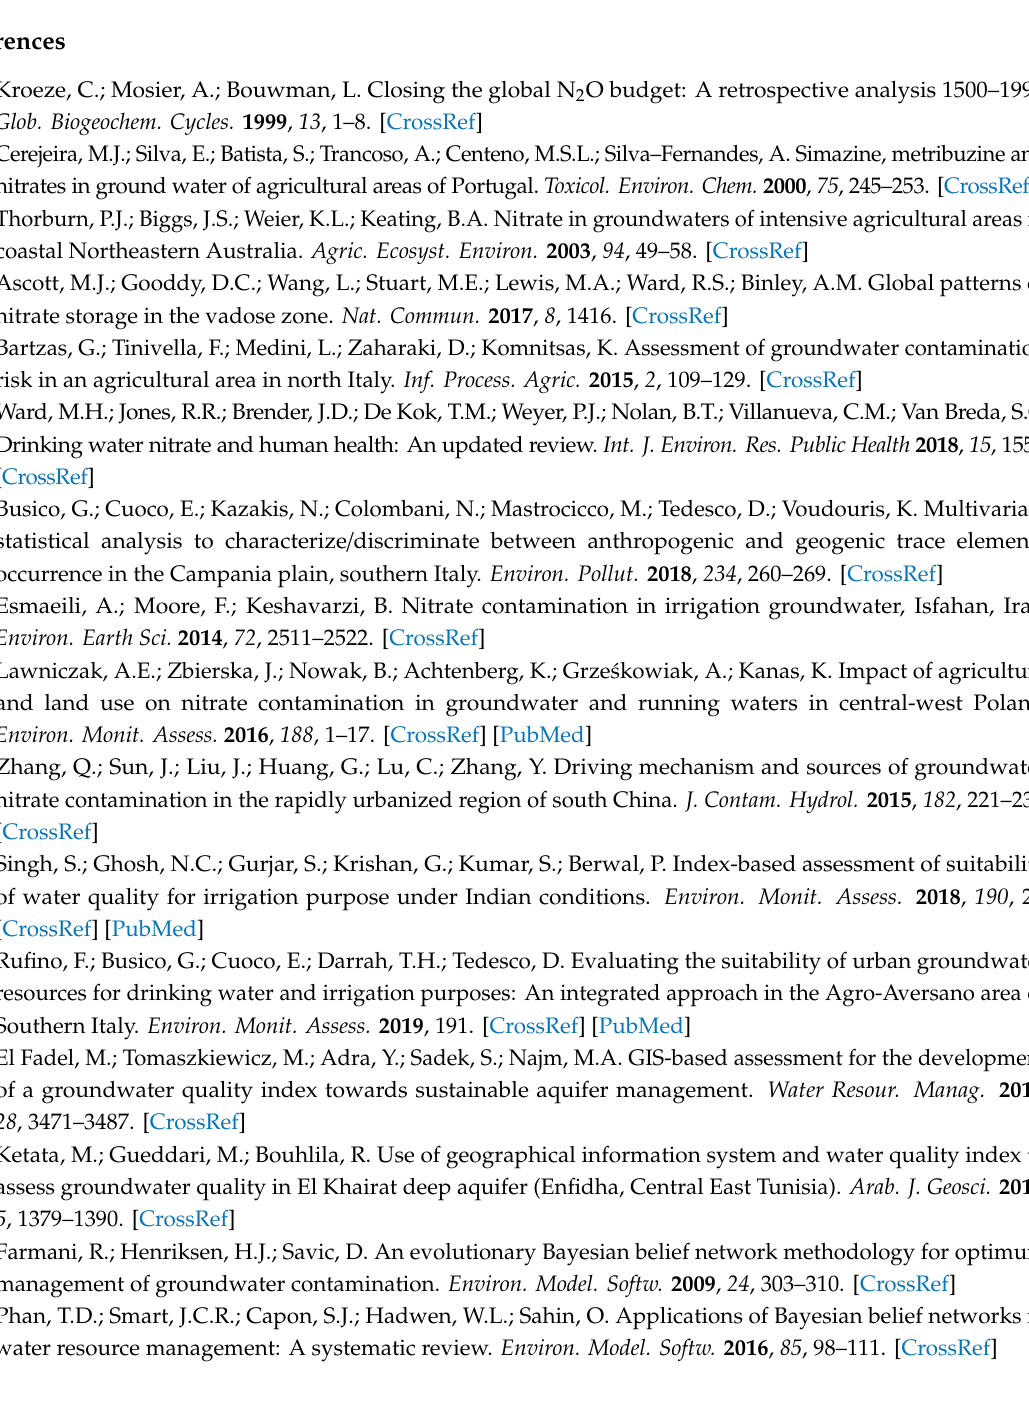
Table S3: Parameters classes for the PNA methodology from Busico et al. [36], Table S4: General statistic of groundwater samples, Table S3: Isotopic ratio statistic for the sampled